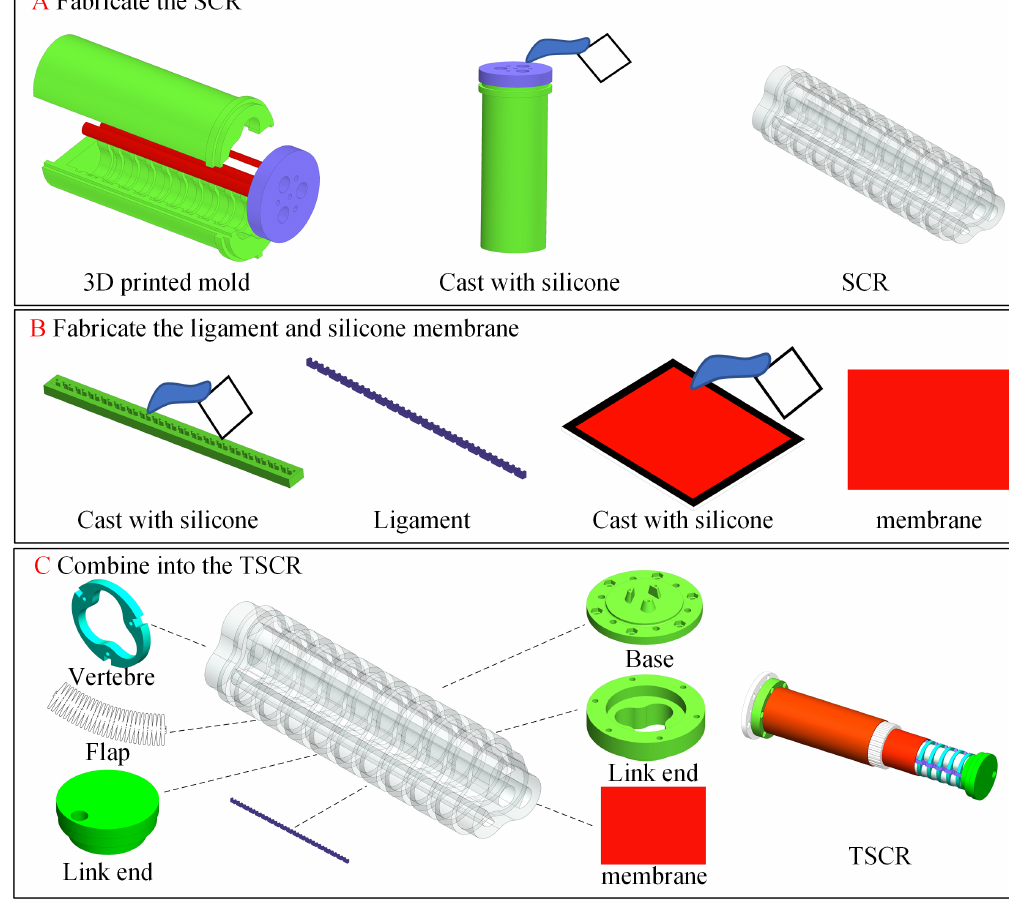
Figure 2. Fabrication of TSCR. ( A ) Fabricate the SCR. Cast uncured silicone (Ecoflex 00-50; Smooth- on, Inc.) into 3D-printed mold. Let the silicone cure to obtain SCR. ( B ) Fabricate the ligament and silicone membrane. Cast uncured silicone (Dragon Skin10 ® 10; Smooth-On) into 3D-printed mold on a flat surface. Let the silicone cure to achieve the ligament and membrane of even thickness. ( C ) Combine all the mentioned components into